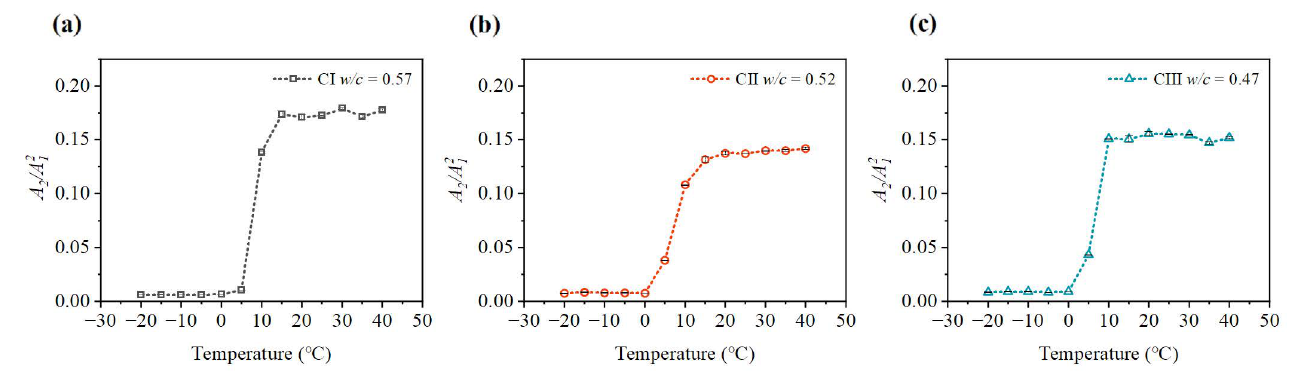
Figure 12. Variation of nonlinear parameter A 2 / A 2 parameter A 2 / A 2 of CI; ( b ) nonlinear parameter A 2 / A 2 1